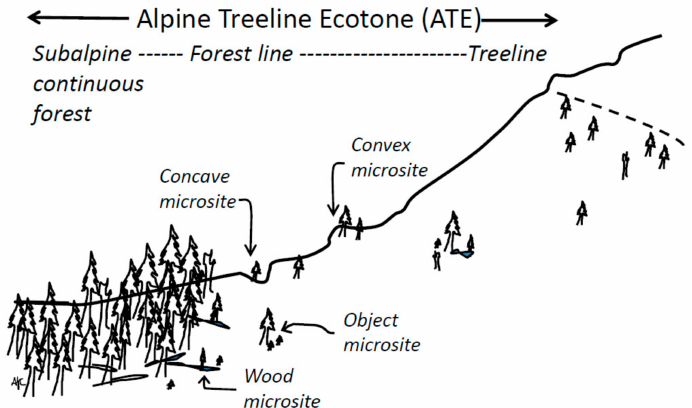
Figure 1. Timberline location and microsite type within the alpine treeline ecotone (ATE). Four microsite types summarized in this study are highlighted. Note ATE width, varying considerably worldwide, varies from abrupt to di ff use in structure. A di ff use ATE ecotone, typical of cool / wet climates is illustrated